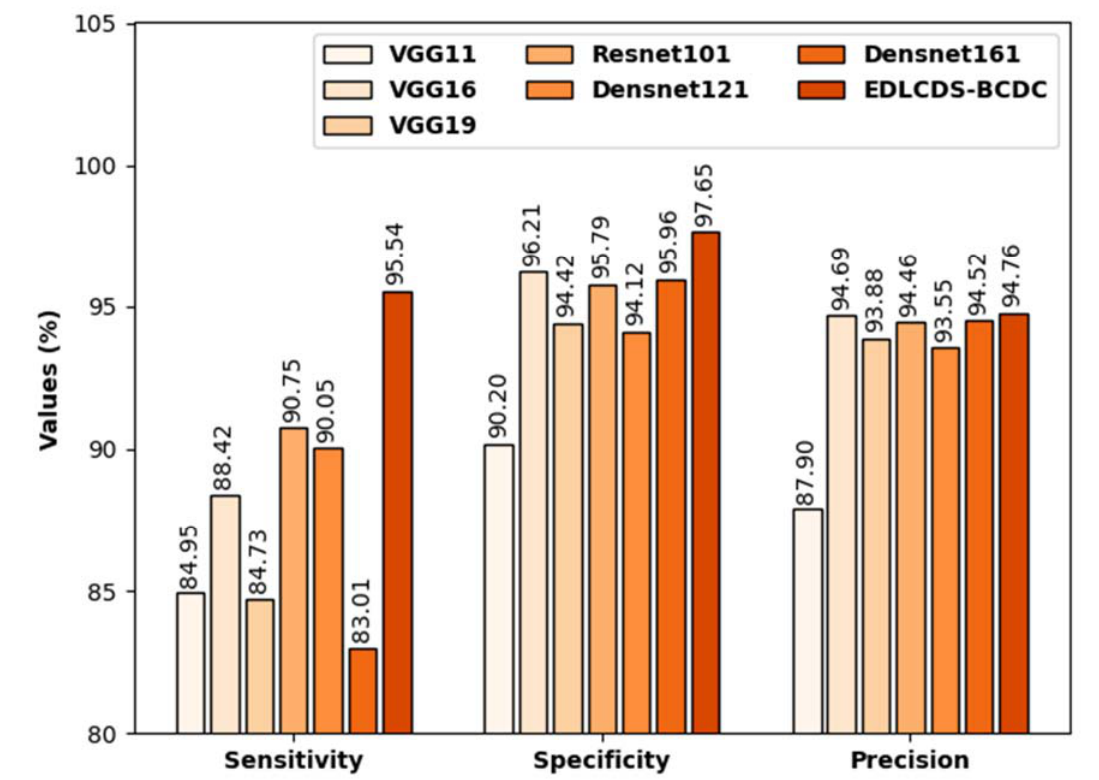
Figure 9. Comparative analysis of the EDLCDS-BCDC technique with recent methods.